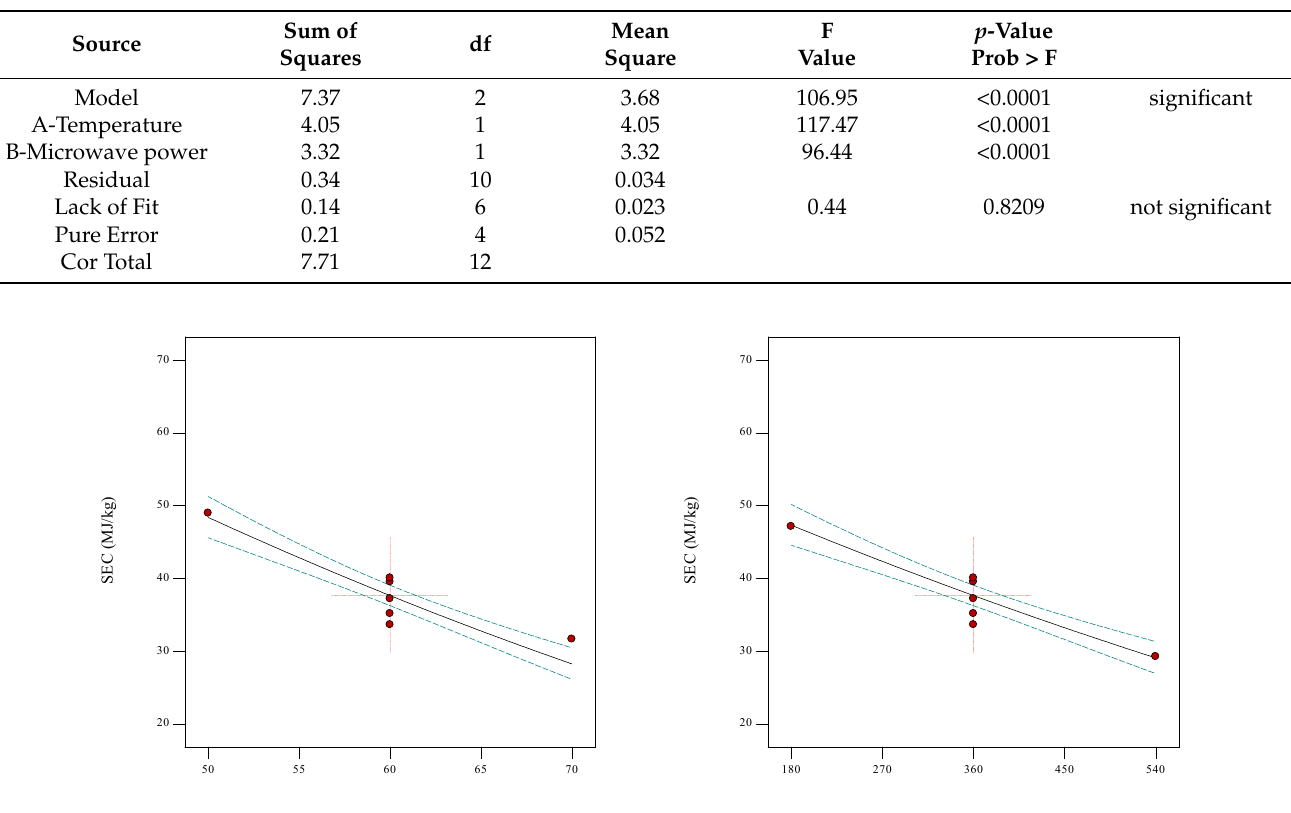
Table 7. Analysis of variance for SEC response using RSM.